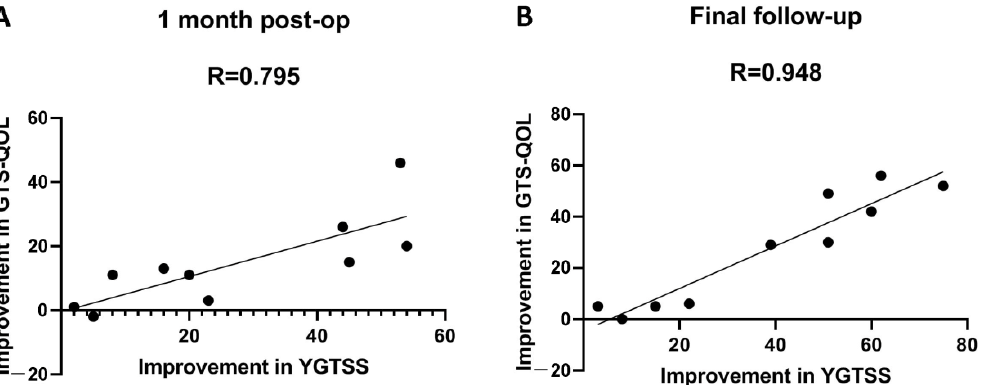
Figure 3. Scatter diagram of the correlation between the decreased score of GTS-QOL and YGTSS. Improvement in YGTSS total score (x-axis) correlates with improvement in GTS-QOL score (y-axis) both one month after operation ( A ) and at the final follow-up ( B ). Each black dot represents a case (4 – 13).